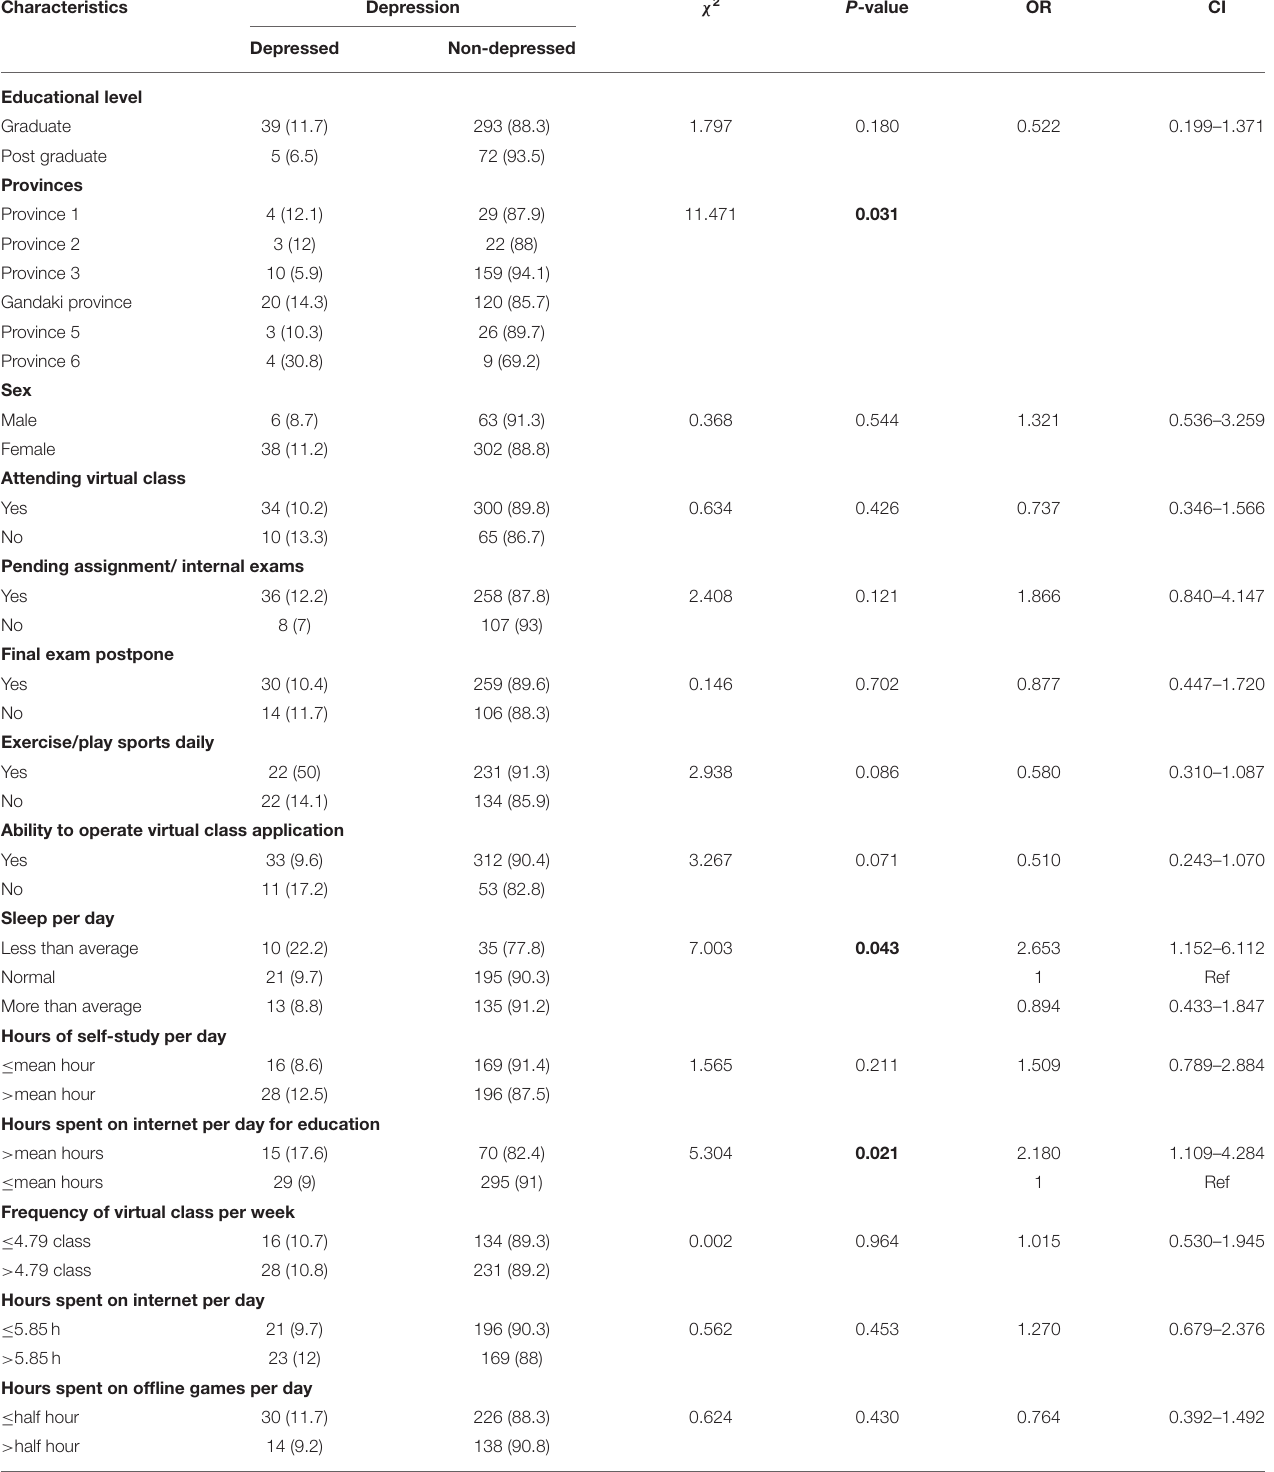
TABLE 7 | Bi-variate analysis between depression and different variables ( n = 409).